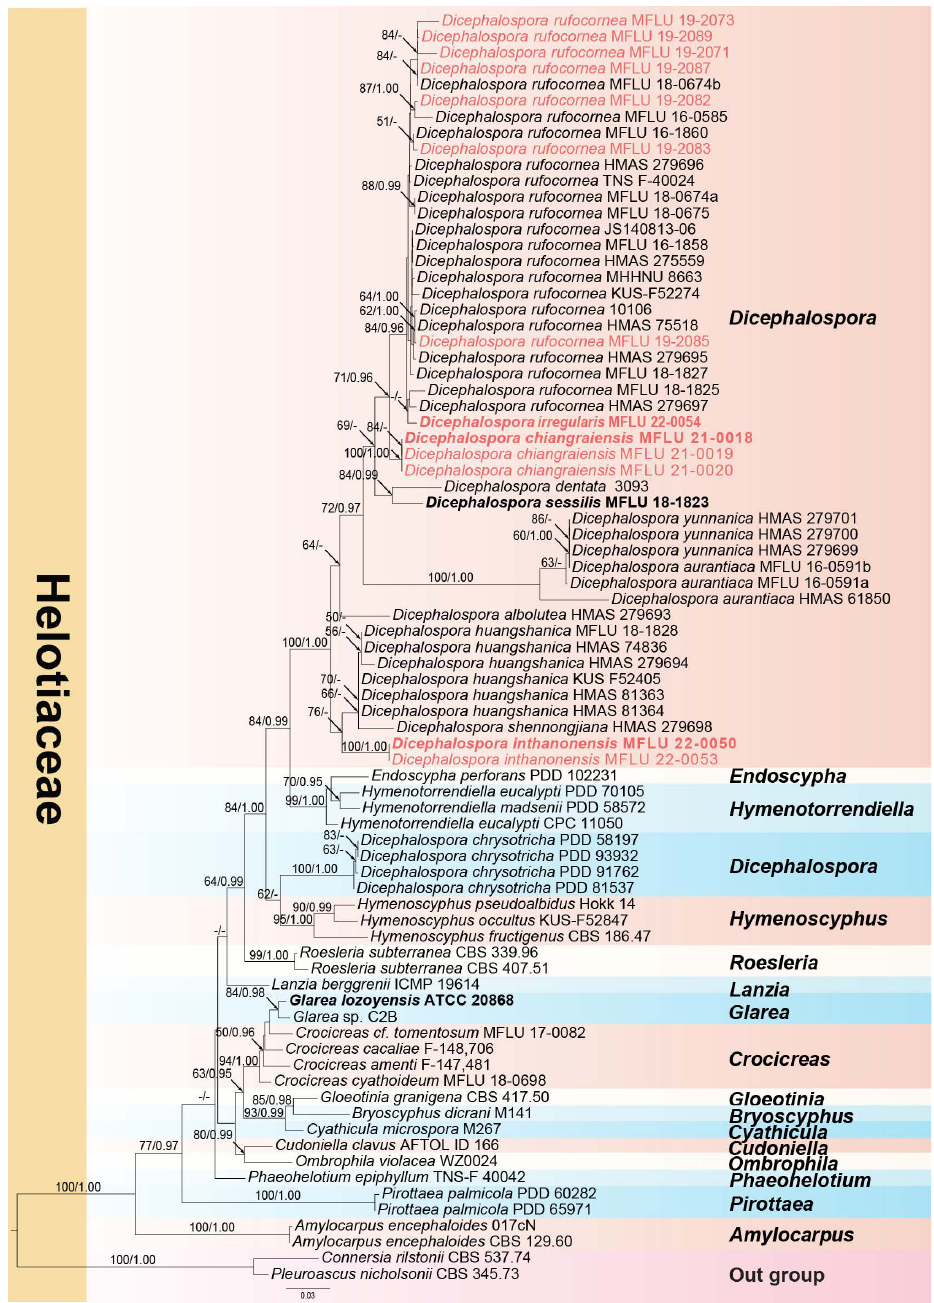
Figure 1. Phylogram of RAxML analysis based on combined LSU and ITS sequence dataset. Boot- strap support values for maximum likelihood equal to or greater than 50%, and Bayesian posterior probabilities equal to or greater than 0.95 BYPP are indicated at the nodes as ML/BYPP. The tree is rooted to Connersia rilstonii (CBS 537.74) and Pleuroascus nicholsonii (CBS 345.73). Ex-type strains are in bold . The newly generated sequences are in red